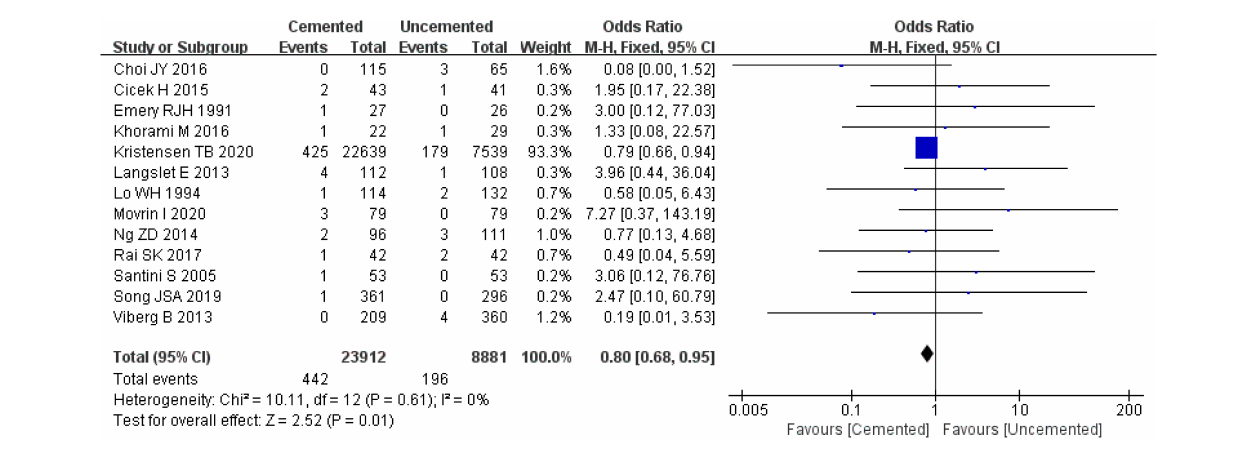
FIGURE7 Forest plot for comparison of wound infections between cemented bipolar hemiarthroplasty (CBH) group and uncemented bipolar hemiarthroplasty (UCBH) group.